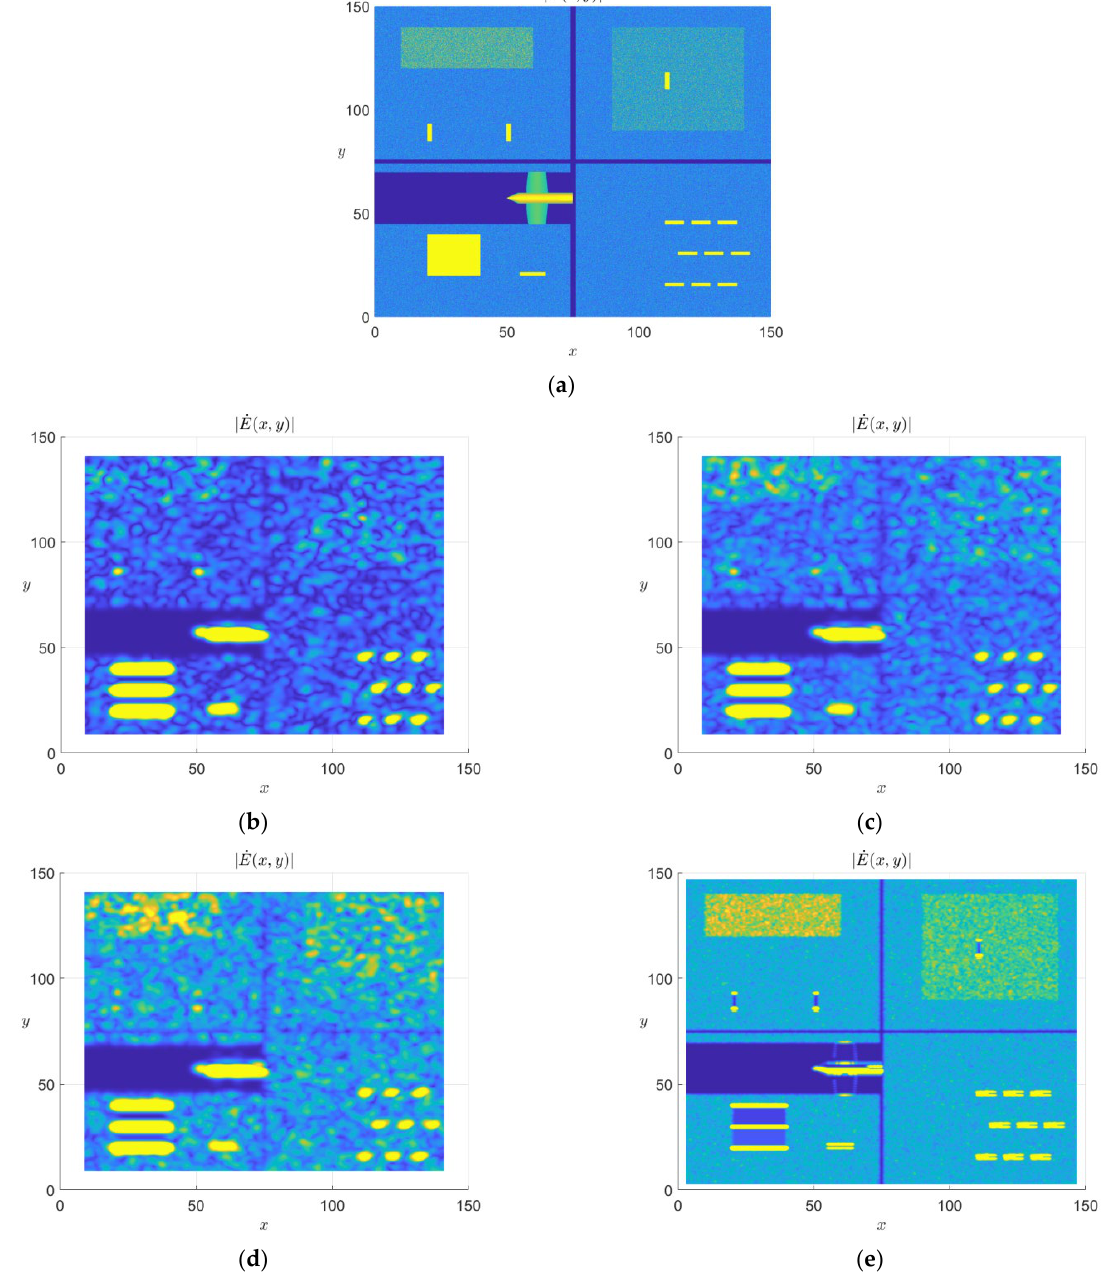
  (cid:12) (cid:12) . → |Y(r)| : ( a ) true coherent image, ( b ) radar (cid:12) (cid:12) Y ( r ) (cid:12) (cid:12) : ( a ) true coherent image, ( b ) radar system